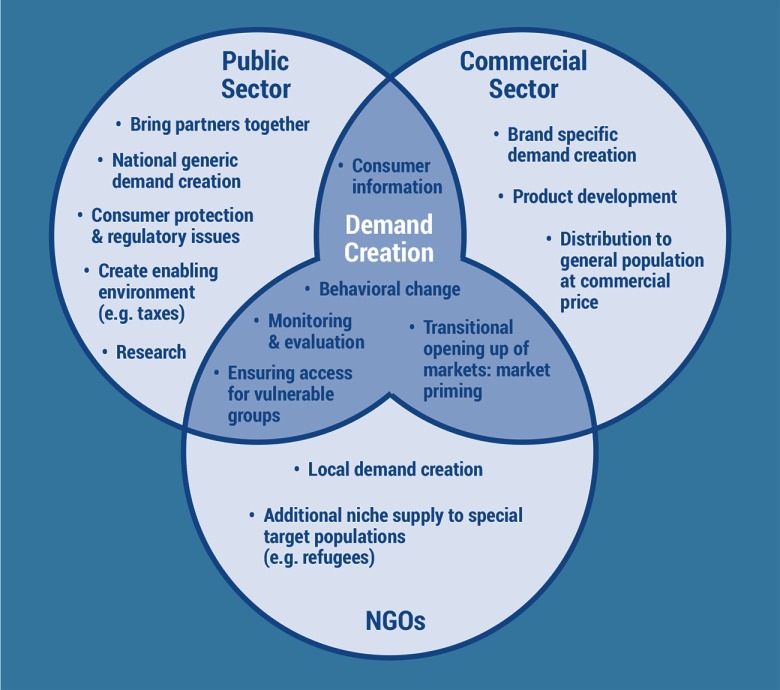
Roles of the Public Sector, NGOs, and the Commercial Sector in Creating an Enabling Environment for ITN DistributionAbbreviation: ITN, insecticide-treated net.Source: WHO (2003).10